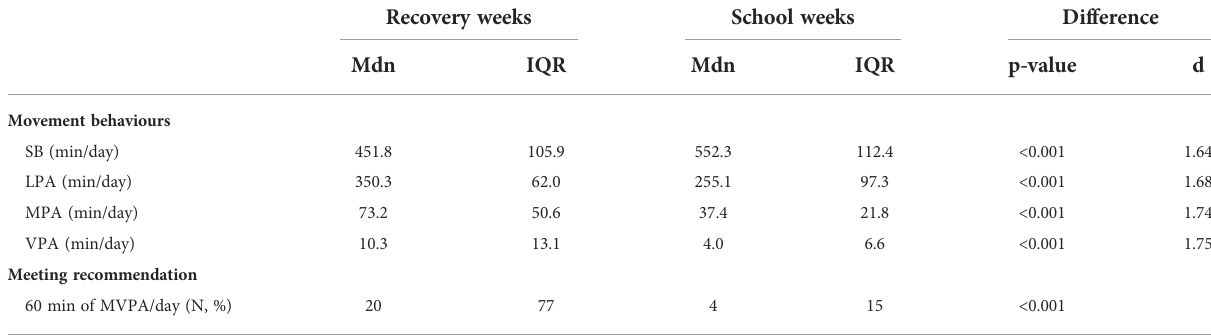
TABLE 2 Movement behaviours and meeting of recommended PA level in paediatric cancer survivors during recovery and school